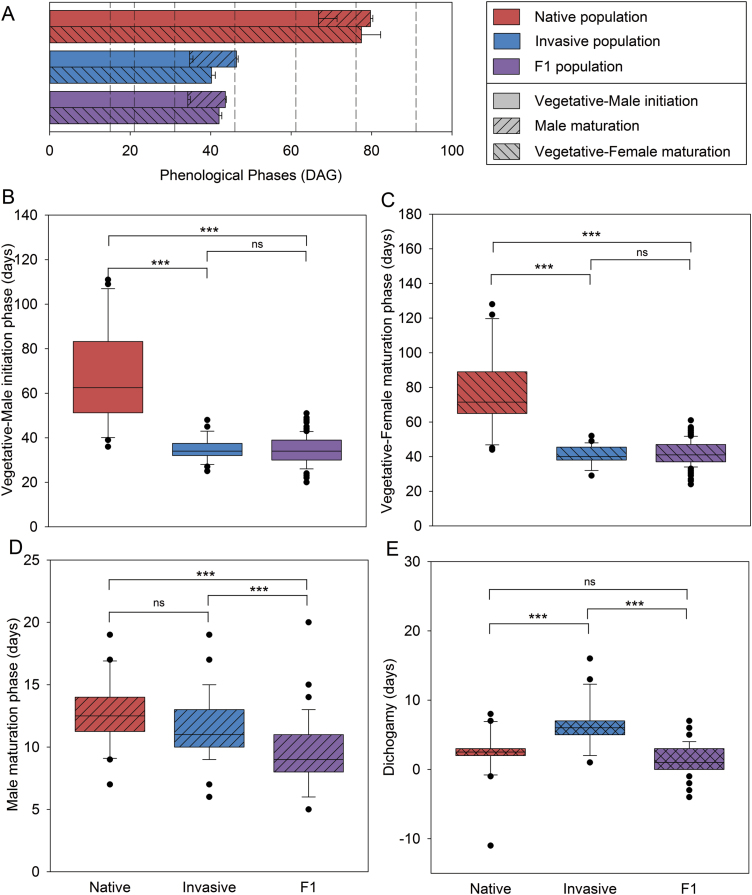
Flowering phenology of the native, invasive, and F1 populations. (A) Averages of the different phenological phases together for the native population (red, n=20), the invasive population (blue, n=36), and the F1 population (purple, n=111). Dashed vertical lines indicate times of sample collection for gene expression analysis. (B) Length of the vegetative-male initiation phase. (C) Length of the vegetative-female maturation phase. (D) Length of the male maturation phase. (E) Degree of dichogamy, expressed by the time between the appearance of the first mature male flower and the appearance of the first mature female flower. Box plots show the first, second, and third quartiles (the box), the 10th and 90th percentiles (the whiskers), and outliers as individual dots. Mann–Whitney U-tests were performed to test for significant differences between groups (ns P>0.05, ***P<0.001; Bonferroni correction was applied with m=12 to the α of individual comparisons to obtain the indicated overall α values).